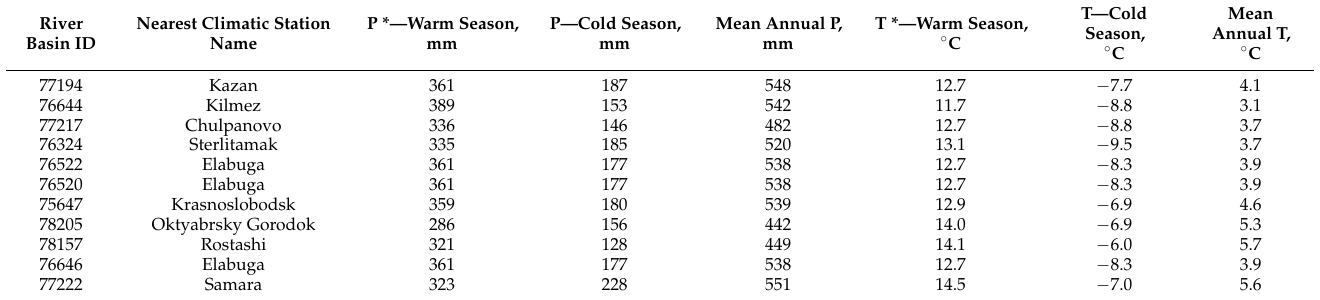
Table 1. Mean annual climatic characteristics of test river basins.